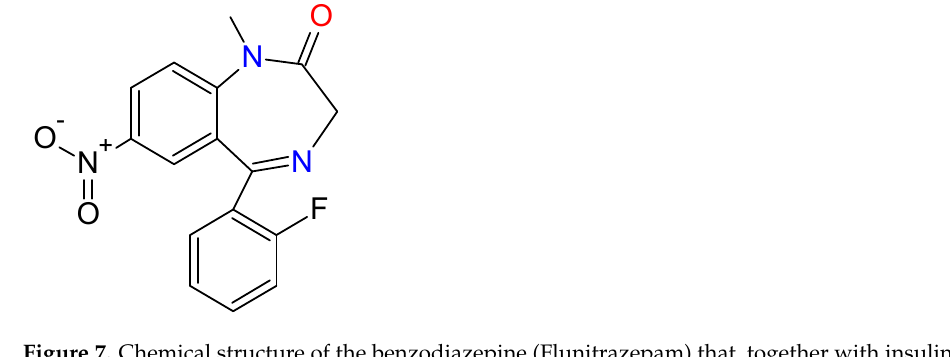
Figure 8. Chemical structure of Diazepam. It is believed that, under its effects, Stephen Paddock killed 58 persons during a concert in Las Vegas (USA), the first of October 2017. It is known that these criminals usually do not think clearly under the effects of the drugs, and after the attacks can have integrated amnesia episodes [49]. In fact, the long- term consumers of these substances can suffer incapacity to feel pain or pleasure, an al- teration known as emotive anesthesia. A study intended to evidence the magnitude of this problem was carried out in France in 2017; it was corroborated that 68 of 140 criminals with any psychiatric disorder done their crimes under the effects of BDZs [50].